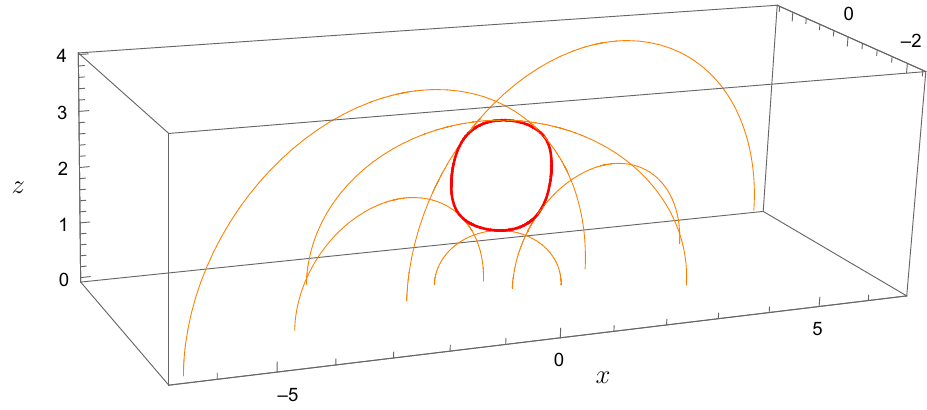
Fig. 7 The red curve is a plot of the undulating circle (74), with ( ¯ t , ¯ x , ¯ z ) = ( 0 , 0 , 2 ) , r = 1, a = 1 / 9 and n = 3. Some of the geodesics tangent to the circle are depicted in orange, for λ/ 2 π = 2 / 16 , 4 / 16 , 6 / 16 , 10 / 16 , 12 / 16 , 14 /